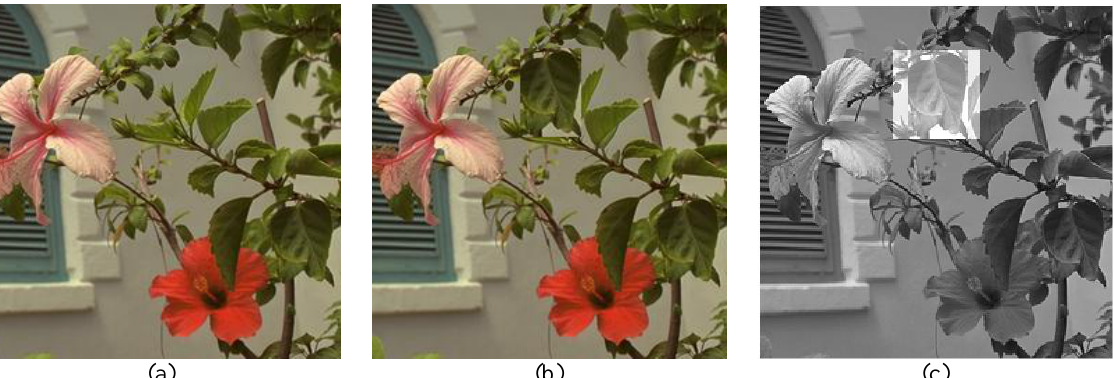
Figure 9. Visualized forged detection results using CSLBP-based hashing method. From the left, columns 1 to 3 are original images, tampered images and detection results, respectively.